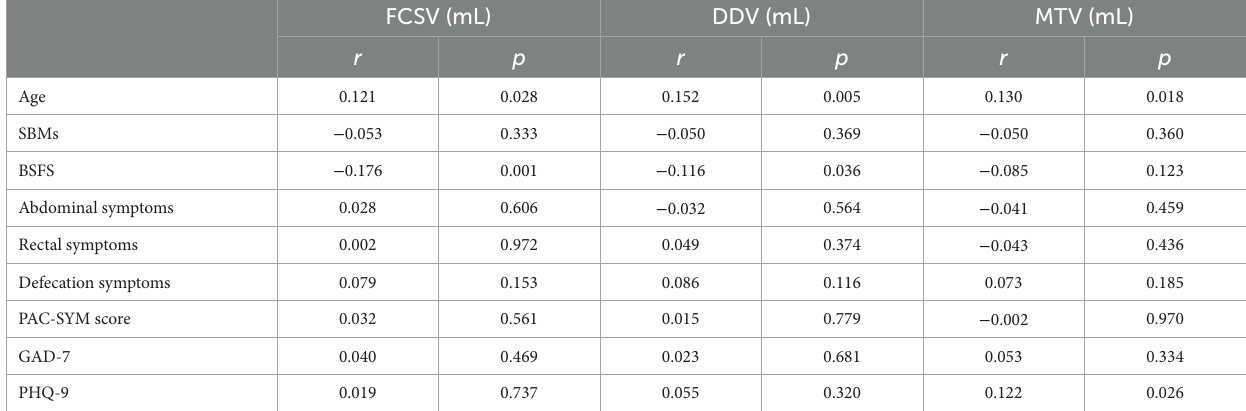
TABLE 6 Relationship between clinical manifestations and 3 rectal sensory thresholds of 311 patients with FDD. FCSV